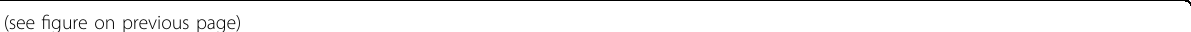
Fig. 1 The synthesis process and morphological feature of NBP-CNW-NTAs/CF and its precursors. A Schematic illustration of the fabrication procedure of the hierarchical structured hybrid microelectrode: (a) activated CF, (b) ZnO-NRAs/CF, (c) ZnO-NRAs@[VEIM]BF 4 -[OMIM]PF 6 /CF, (d) ZnO- NRAs@P[VEIM]BF 4 -[OMIM]PF 6 /CF, (e) ZnO-NRAs@NBP-CNW/CF, and (f) NBP-CNW-NTAs/CF. Step i: Activating CF by immersion in H 2 O 2 ; Step ii: Growth of ZnO-NRAs on CF via electrodeposition; Step iii: Dip-coating IL mixture of [VEIM]BF 4 -[OMIM]PF 6 on ZnO-NRAs; Step iv: Thermal-initiation free-radical polymerization of [VEIM]BF 4 monomer to form P[VEIM]BF 4 layer on ZnO-NRAs by heating from room temperature to 300 °C; Step v- Carbonization of P[VEIM]BF 4 -[OMIM]PF 6 layer into NBP-CNW by heating to 750 °C; Step vi: Removing ZnO-NRAs template to form NBP-CNW-NTAs. SEM images of ( B ) activated CF; inset is the digital photograph of CF. SEM images of ( C – E ) ZnO-NRAs/CF and ( F – I ) NBP-CNW-NTAs/CF at different magni fi cations. J Dark- fi eld and ( K – M ) bright- fi eld TEM images of NBP-CNW at different magni fi cations. N Scanning elemental mapping of